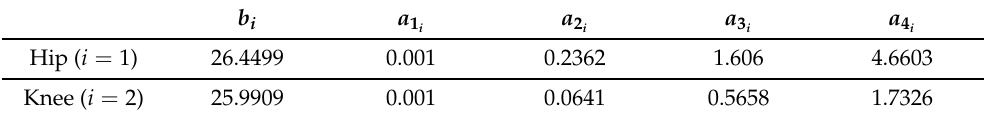
Table 1. Parameters of hip and knee mathematical model.